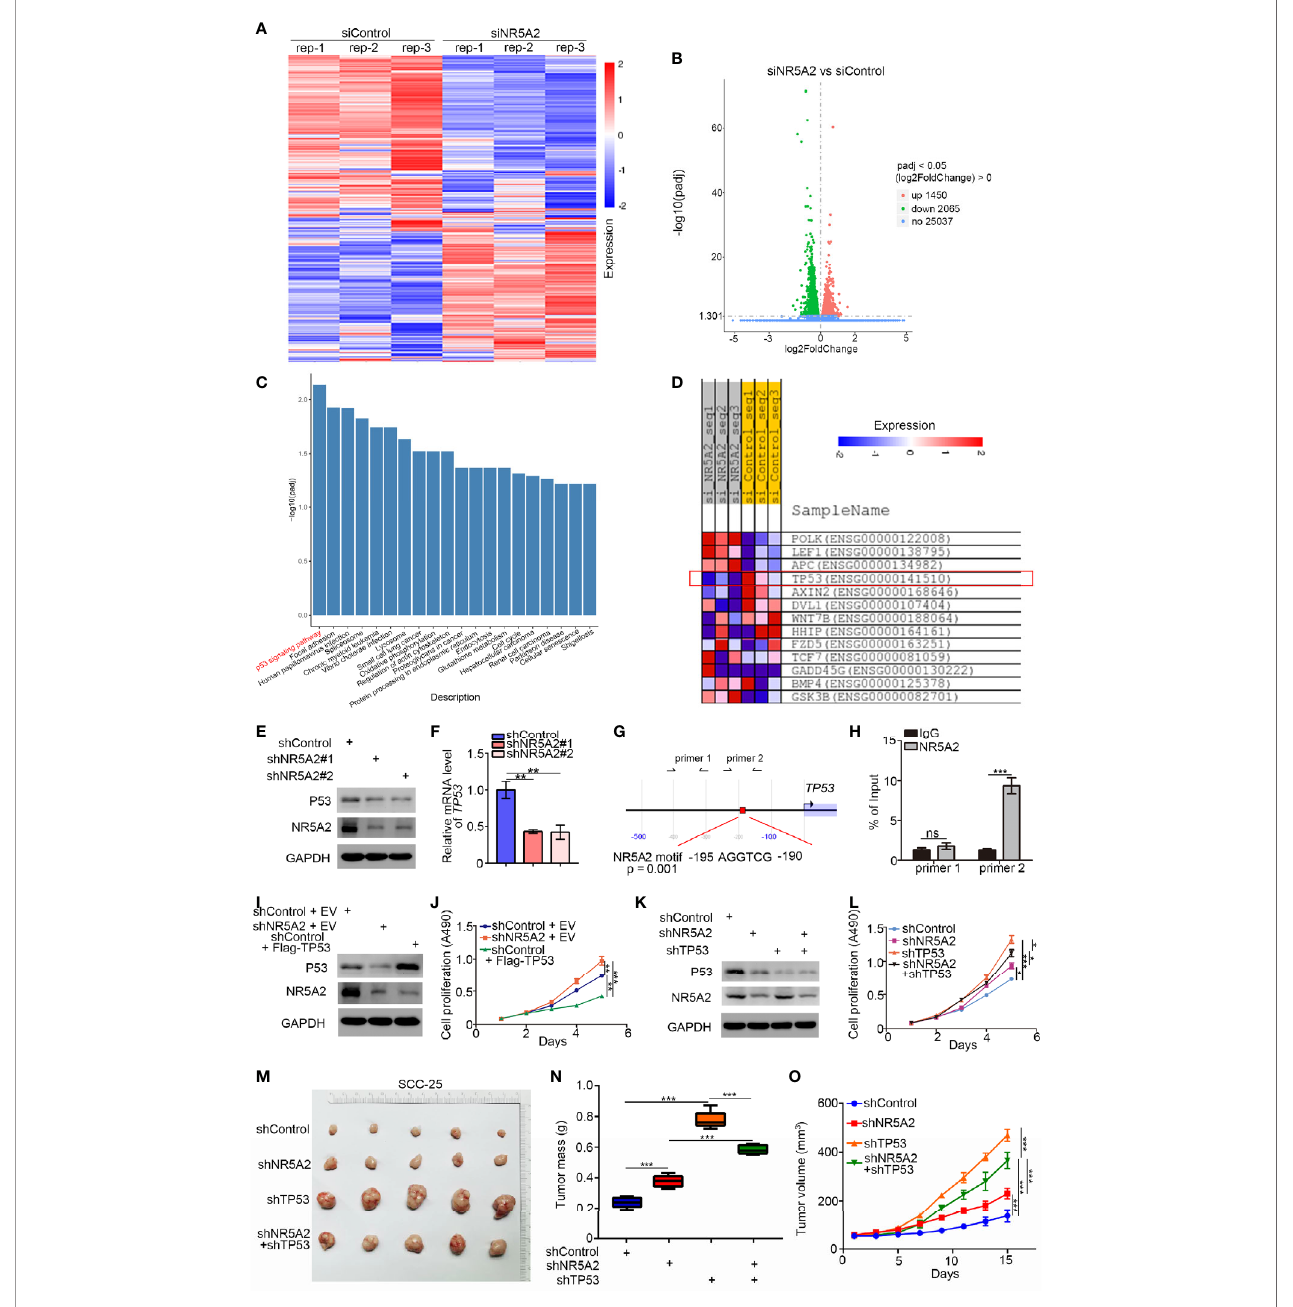
FIGURE 6 | NR5A2 regulates HNSCC cell growth in a p53-dependent manner. (A – D) heatmap (A) and volcano plot (B) to show the differential expressed genes of FaDu cells infected by siControl or siNR5A2. (C) Enrichment analysis suggests that the differential genes between siControl and siNR5A2 groups may related to HNSCC. (D) RNA-Seq data suggest that knocking down NR5A2 correlation with the decrease of p53 expression. (E, F) , 48 h post-infection, FaDu cells were infected with shControl or shNR5A2 were harvested for Western blotting analysis (E) and RT-PCR analysis (F) . The data shown are the mean values ± SD from three replicates. **P < 0.01. (G) , the promoter region of TP53 was searched from The Eukaryotic Promoter Database exhibit that there was a consensus NR5A2 binding sites in the promoter region. (H) , the ChIP-qPCR analysis of FaDu cells. The data shown are the mean values ± SD from three replicates. ***P < 0.001. (I, J) , FaDu cells were infected with indicated shRNAs. After 48 h, cells were transfected with indicated plasmids (Empty vector (EV) and Flag-TP53) for another 24 h. Cells were harvested for Western Blot (I) and cell proliferation assay (J) . The data shown are the mean values ± SD from three replicates. **P < 0.01; ***P < 0.001. (K – O) , FaDu cells were infected with indicated shRNAs. 72 h post infection, cells were harvested for Western blotting (K) , MTS assay (L) , or xenografts assay (M) . The tumor volume was measured every three days (N) . Then the tumors were harvested, photographed (M) and weighed (O) . For MTS assay, data are shown as means ± SD (n = 3). *P < 0.05, ***P < 0.001. For xenograft assay, data are shown as means ± SD (n = 5). ***P <